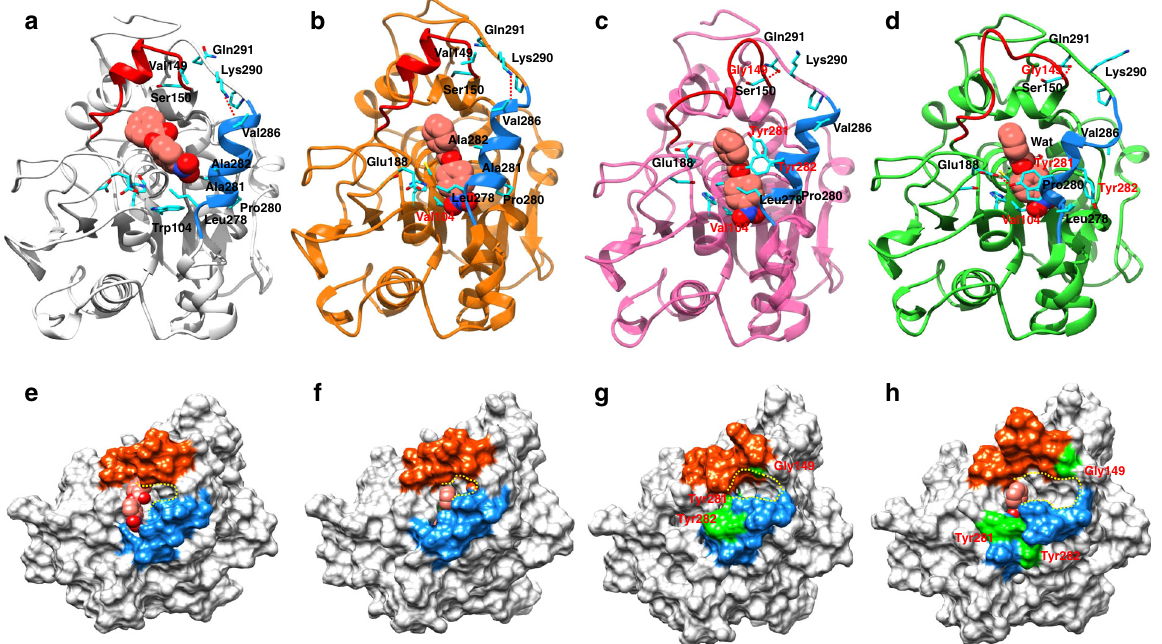
Fig. 4 The binding modes and surface representation of substrate 1 in CALB and its mutants. The structures were obtained from cluster analysis of the 100- ns MD trajectory. a and e , WT CALB after 15 ns of MD simulation. b and f , Variant QW2. c and g , Variant QW10. d and h , Variant QW4. Loop 137 – 150 is shown in red cartoon and surface. Helix 277 – 288 is shown in blue cartoon and surface. Substrate 1 is shown as a red H-bond with substrate 1 in QW4 (Fig. 4d), may be critical for the subsequent hydrolysis reaction, and therefore also be responsible for its high catalytic ef fi ciency.